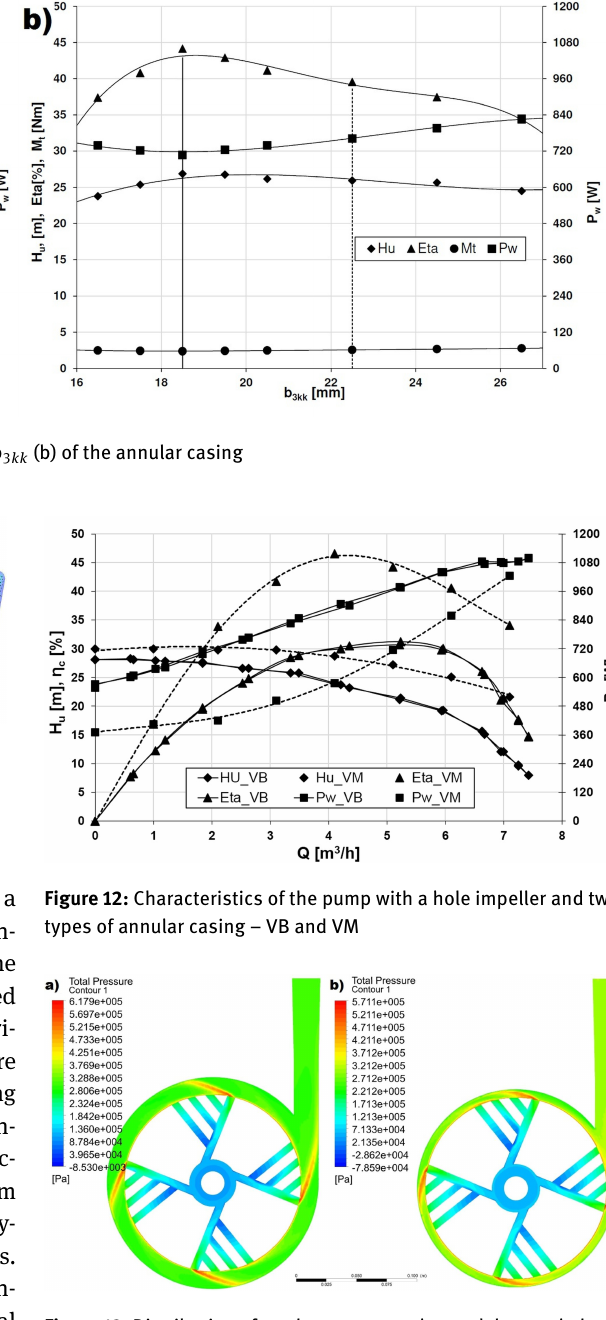
Figure 13: Distribution of total pressure on the model central plane (a) base annular casing VB and (b) final annular casing